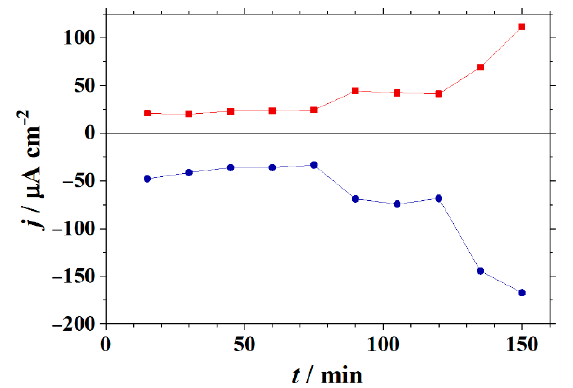
Figure 7. Time courses of current densities determined at the main peaks associated with adjacent cathodic (blue) and anodic (red) regions on SVET maps obtained over the cut edge of a galvanized steel sample after removing the organic coatings from each side (i.e., corresponding to sketch #2 in Figure 1C) immersed in 1 mM NaCl